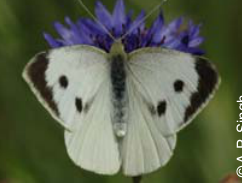
Image 125. Himalayan Black Vein, Aporia leucodice